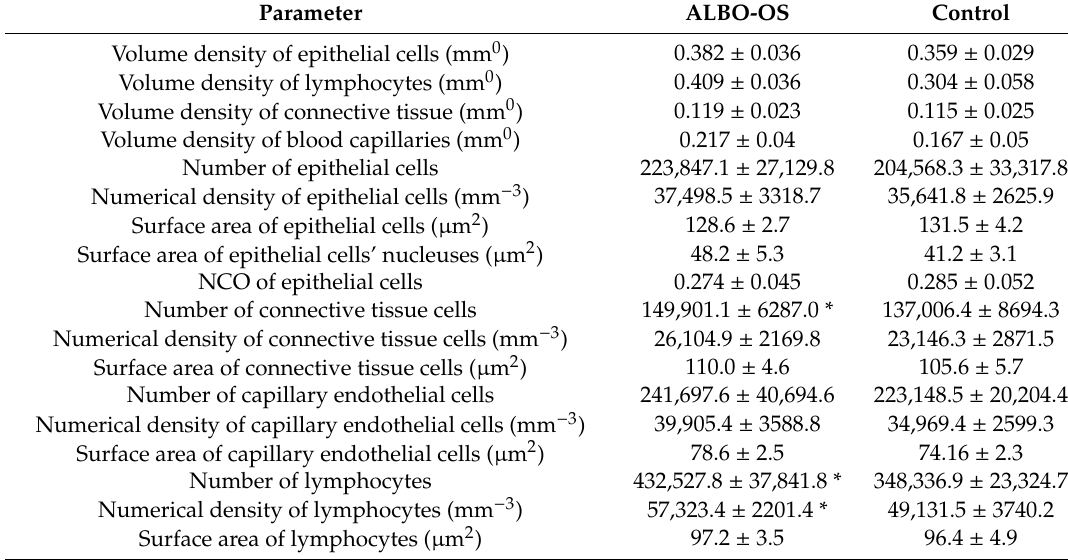
Table 5. Stereological parameters of the spleen of the control group and treated group; values are shown as mean ± SD (* p < 0.05; t